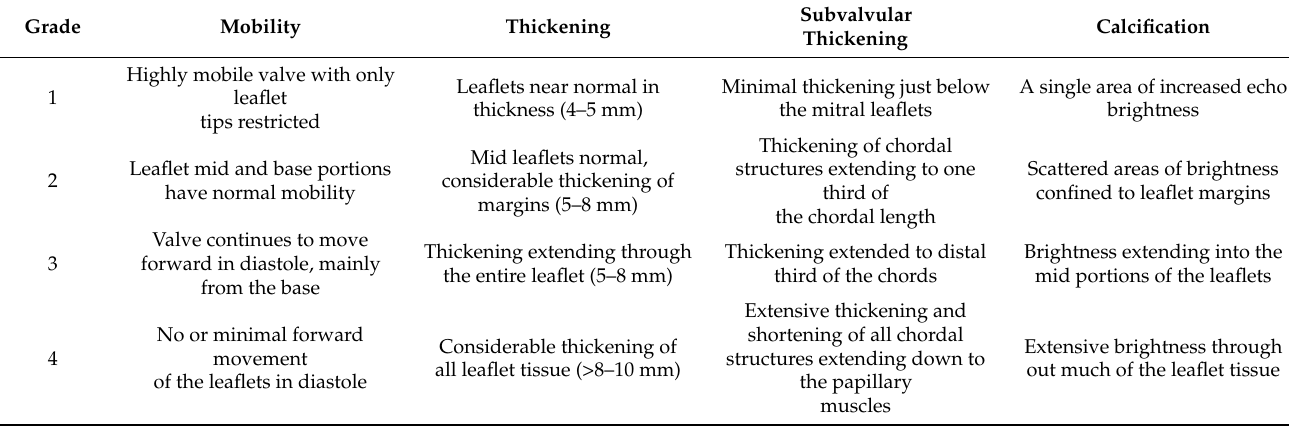
Table 2. Wilkins score. The total score is the sum of the items (ranging from 4 to 16). Adapted from Wilkins et al. [17].